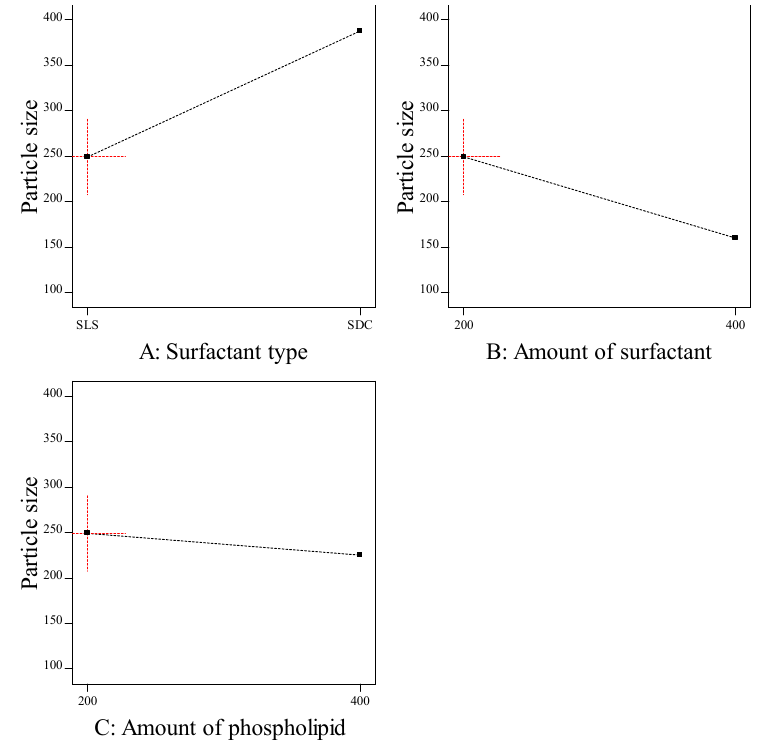
Figure 2. The effect of formulation factors on the particle size (Y2) .